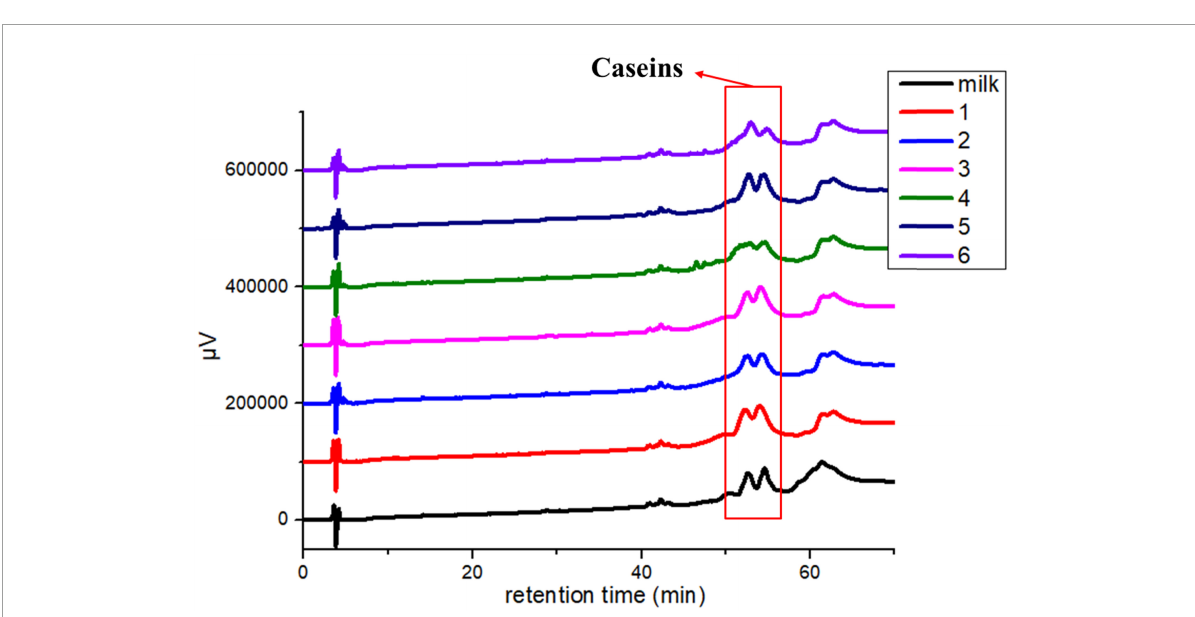
FIGURE2 Reverse phase-HPLC profiles of yogurts. Lane 1: GuMi yogurt; Lane 2: JSD yogurt; Lane 3: HR yogurt; Lane 4: HN yogurt; Lane 5: JA yogurt; Lane 6: HS